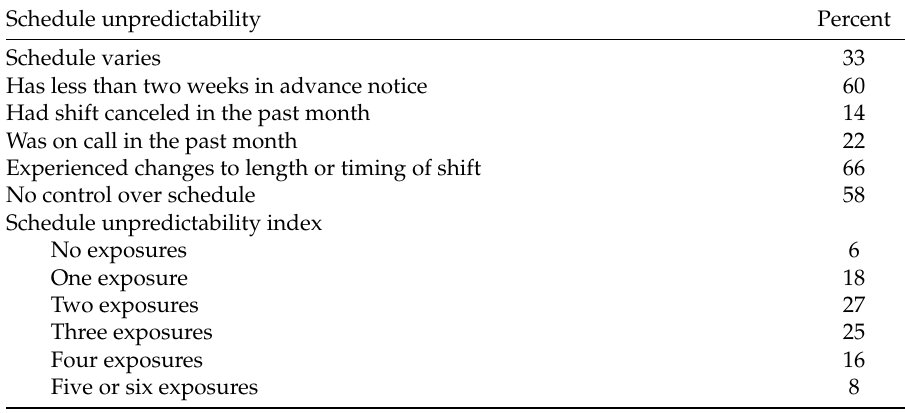
Table 2: Prevalence of schedule